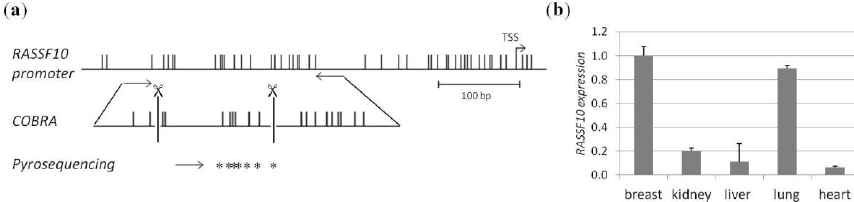
Figure 1. RASSF10 promoter structure and normal expression levels ( a ) The RASSF10 promoter with its CpG island structure. Black vertical lines represent single CpGs and restriction enzyme Taq I recognition sites are marked. Bent arrow indicates transcriptional start site (TSS). Horizontal arrows mark PCR products. PCR product size was 241 bp for COBRA methylation analysis. Restriction site positions for COBRA are shown. Pyrosequencing covers seven CpGs (asterisks) within the COBRA analysed region. 100 bp standard is shown; ( b ) RASSF10 expression is shown relative to b-Actin expression in human breast, kidney, liver, lung and heart RNA samples of healthy donors after reverse transcriptase PCR and quantitative PCR.